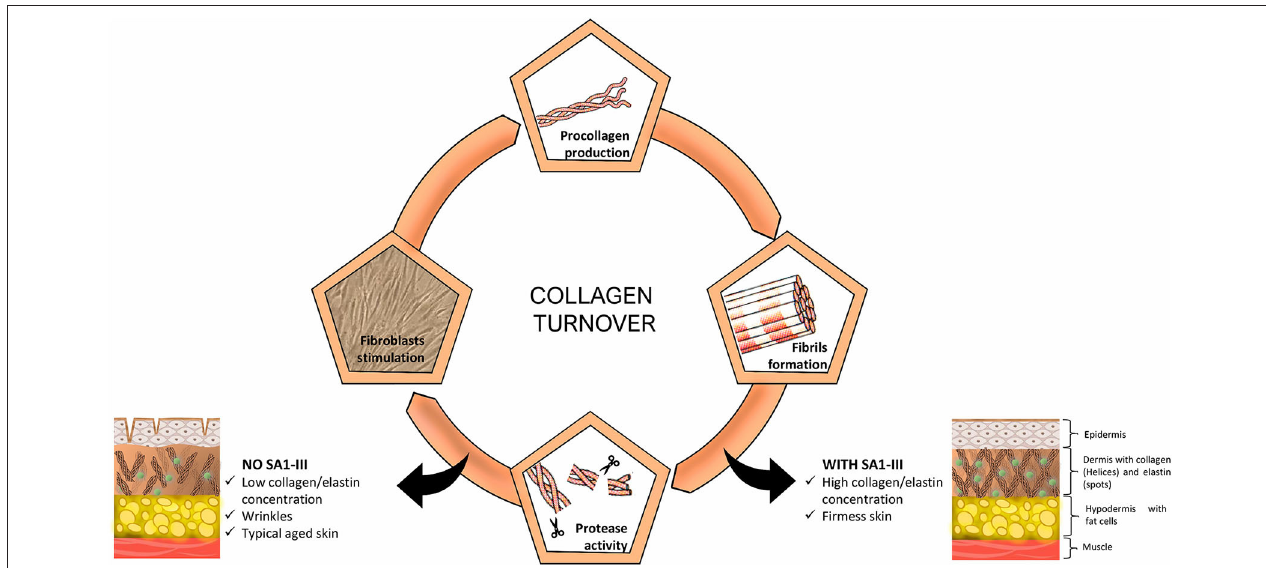
FIGURE 2 | Influence of SA1-III peptide (KP1) on collagen turnover in human dermis.